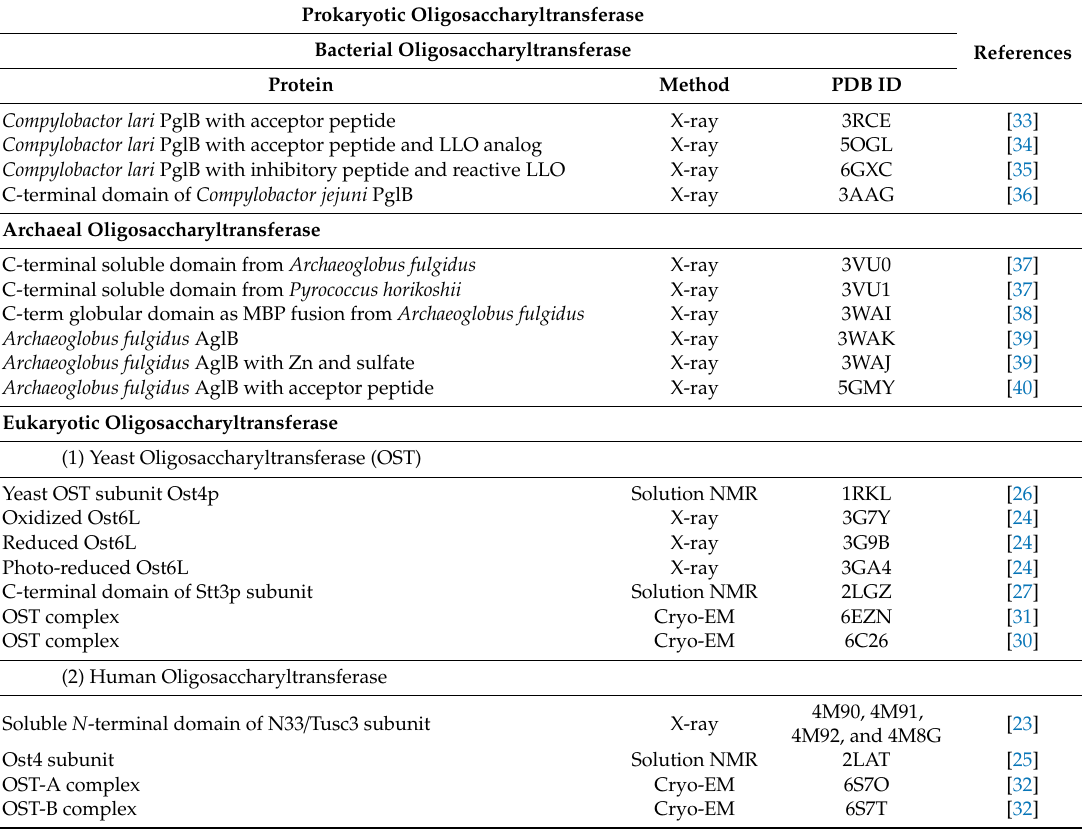
Table 2. List of all the high-resolution structures determined by various methods thus far with their PDB